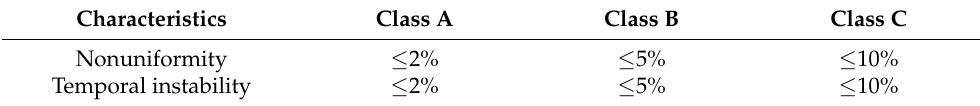
Table 1. Classification of solar simulator performance.